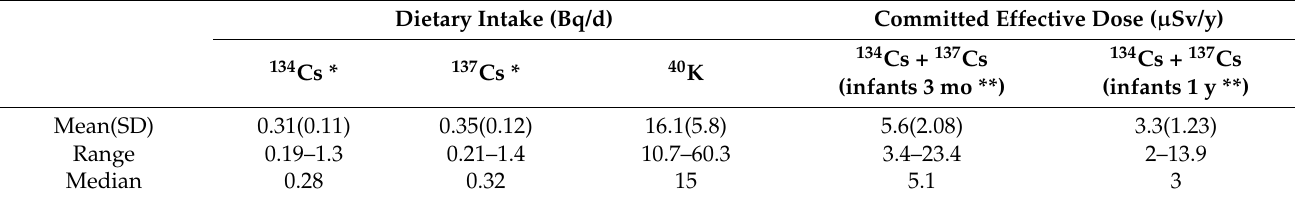
Table 3. Estimated dietary intake of radiocesium via breastmilk and comitted effective dose in infants at 3 months and 1 year ( n = 101).